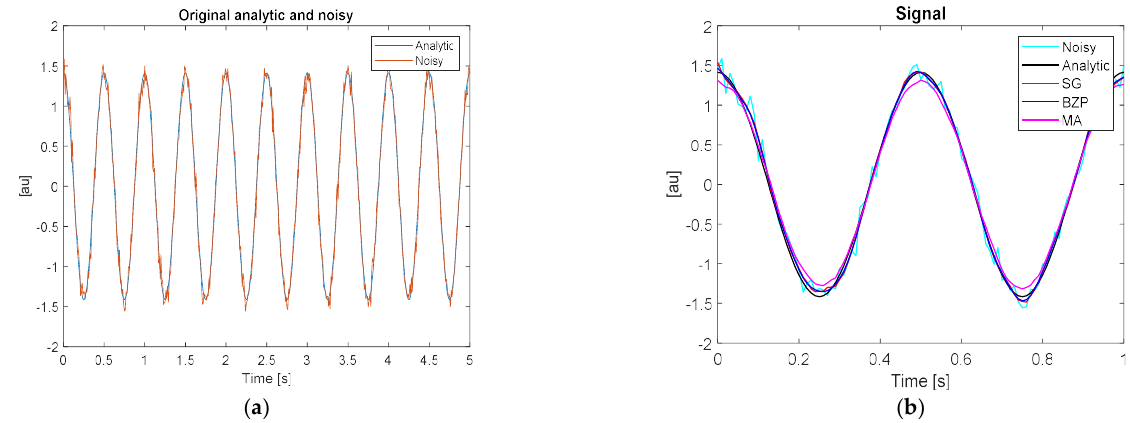
Figure 3. Reference analytical and noisy signals. ( a ) Time histories; ( b ) filter effect detail for polynomial, SG, (red), moving average, MA, (magenta) and Butterworth zero phase, BZP (blue), compared to the reference analytic (black) and noisy (cyan) signals.